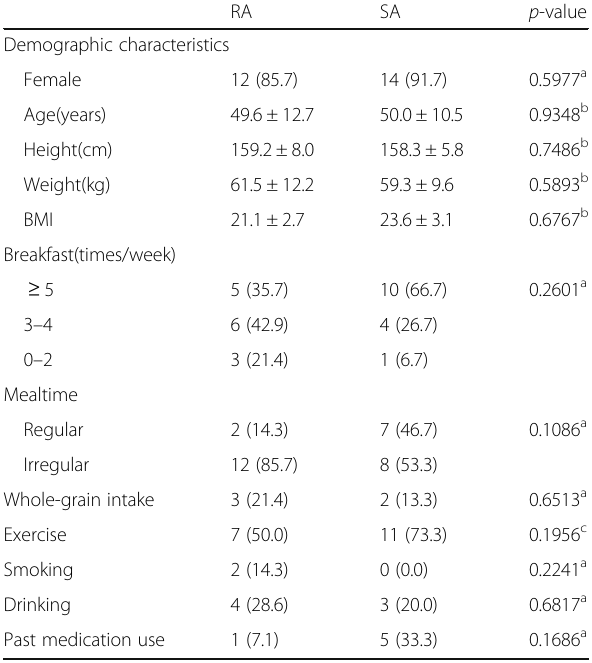
Table 1 Baseline demographic and general characteristics RA SA p -value Demographic